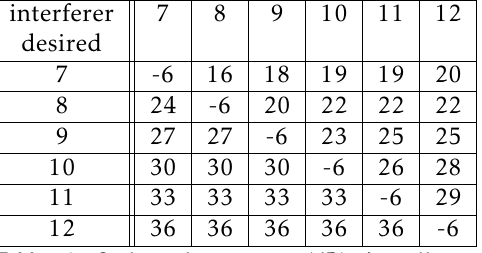
successful if one signal is received at least 6 dB above the other (Table